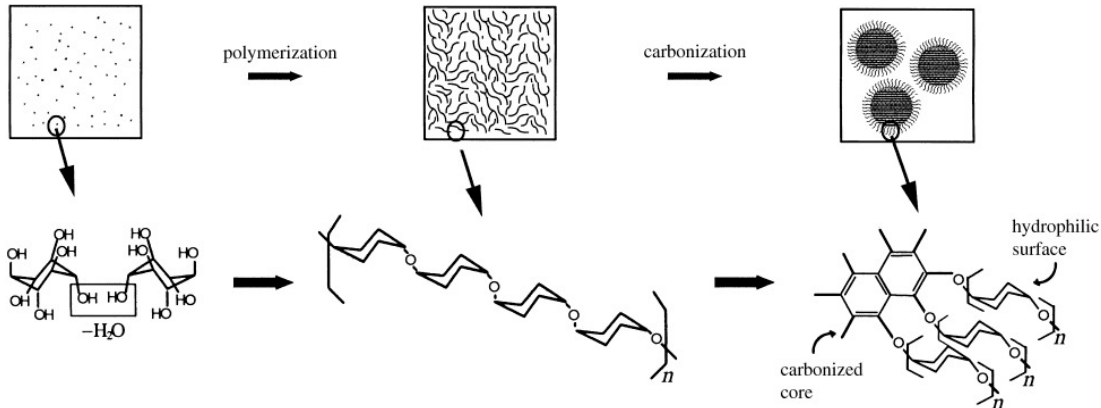
Figure 1. Schematics of the possible synthesis procedure of carbon spheres. Reproduced with permission from [32]. Copyright WILEY, 2004.